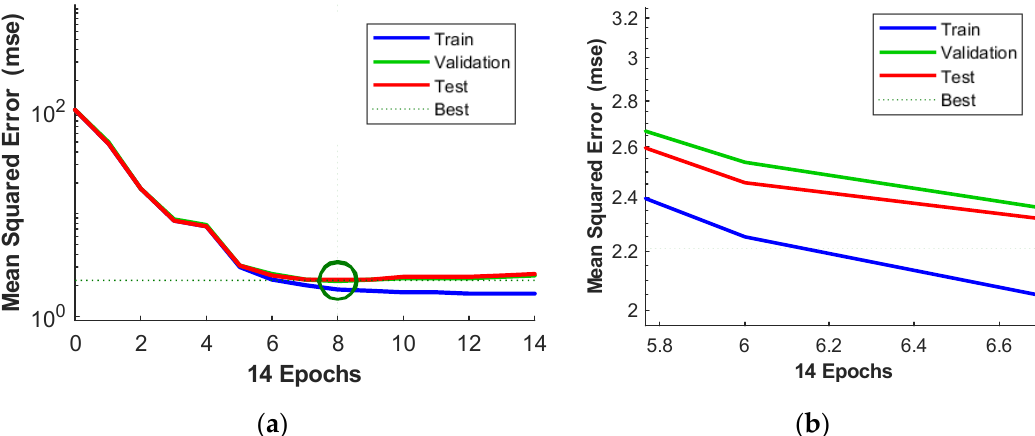
Figure 9. Validation performance through MSE: ( a )—best validation performance MSE = 2.2071 at epoch 8, ( b )—close-up of a section of Figure 9a.